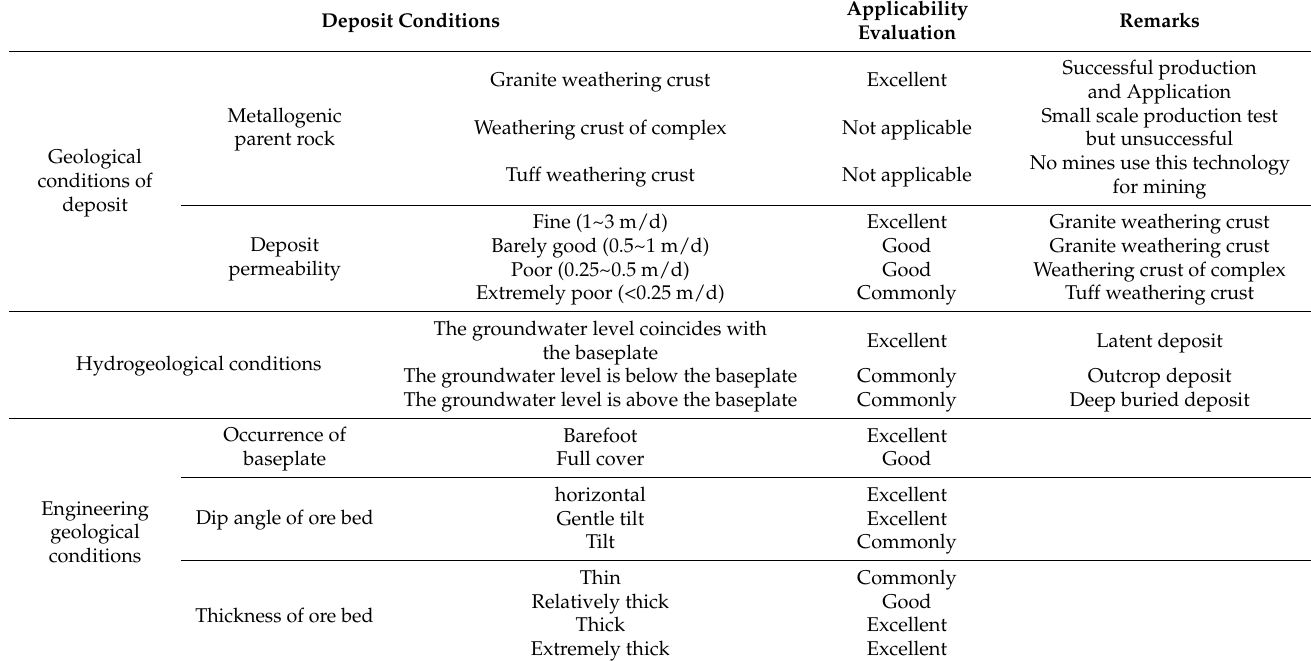
Table 3. Adaptability evaluation of in situ leaching process